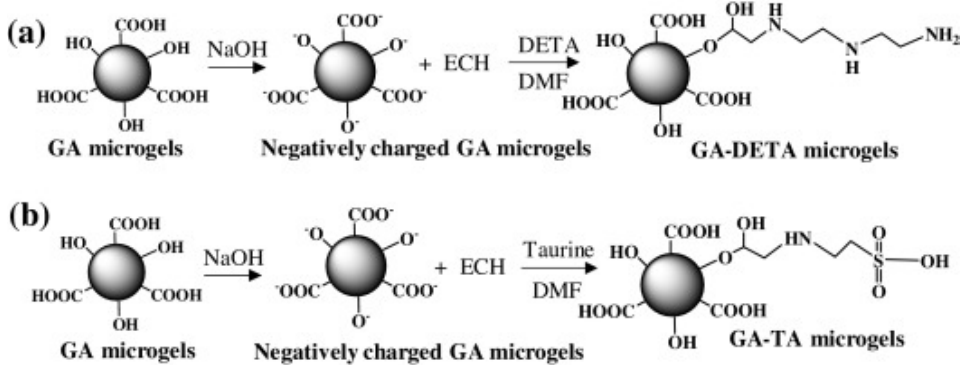
Figure 5. Schematic representation of the modification of GA microgels by ( a ) DETA and ( b ) TA. Reproduced from [66] with permission.